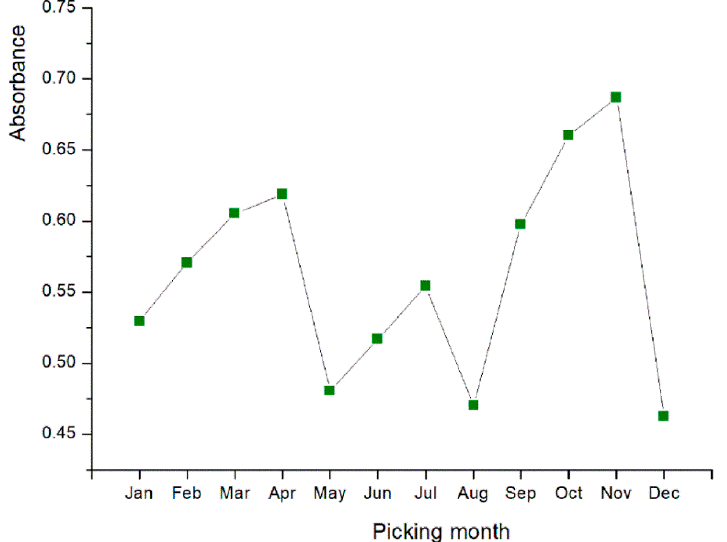
Figure 2. The absorbance variation of 12 sample solutions (5 mg/mL) in the radical reducing power reaction.